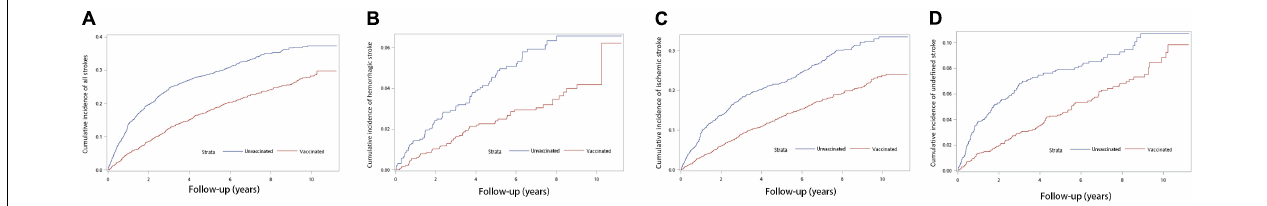
FIGURE 2 | Cumulative incidence rates of different types of strokes estimated by the cumulative incidence function competing risk analysis between patients with and without vaccination. (A) Overall stroke events ( χ 2 = 79.308; df = 1; P < 0.001). (B) Hemorrhagic stroke events ( χ 2 = 13.466; df = 1; P < 0.001). (C) Ischemic stroke events ( χ 2 = 81.272; df = 1; P < 0.001). (D) Undefined stroke events ( χ 2 = 18.660; df = 1; P < 0.001).